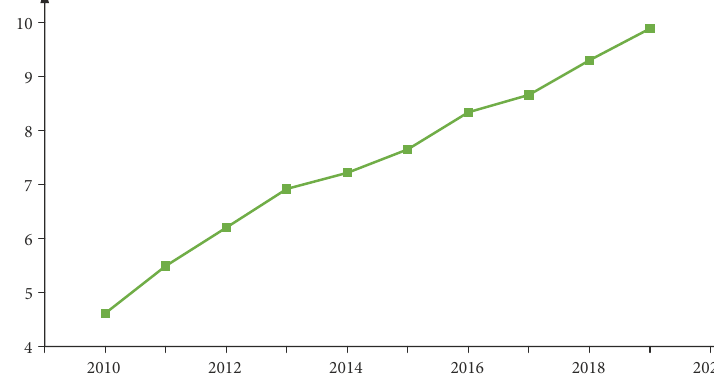
Figure 6. Change trend chart of the digital economy index in 2010–2019